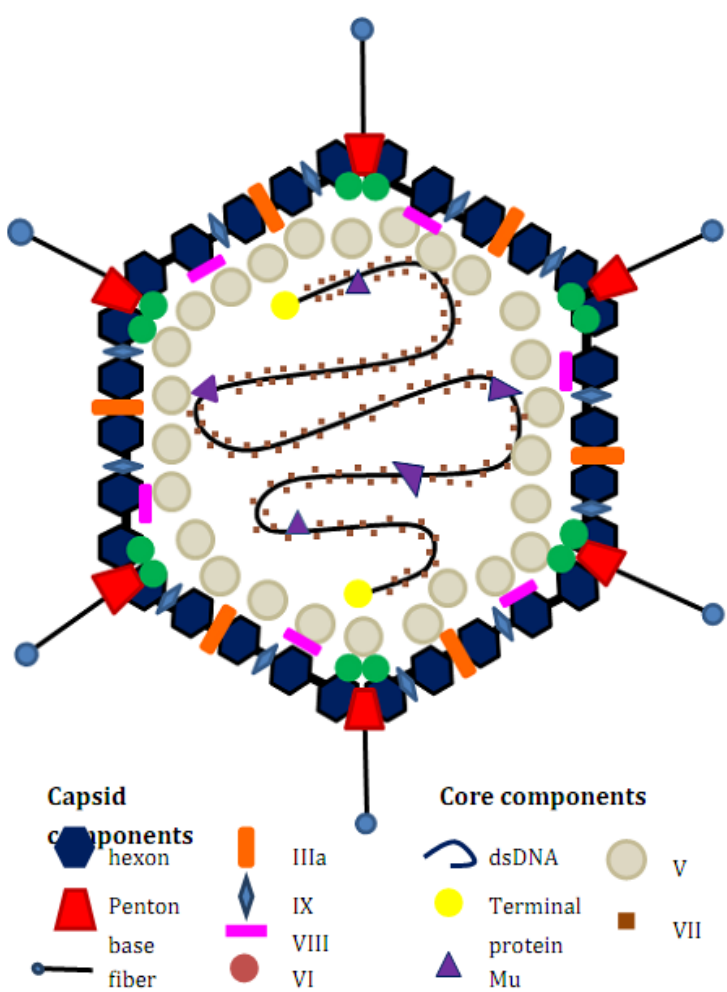
Figure 1. Structure of an